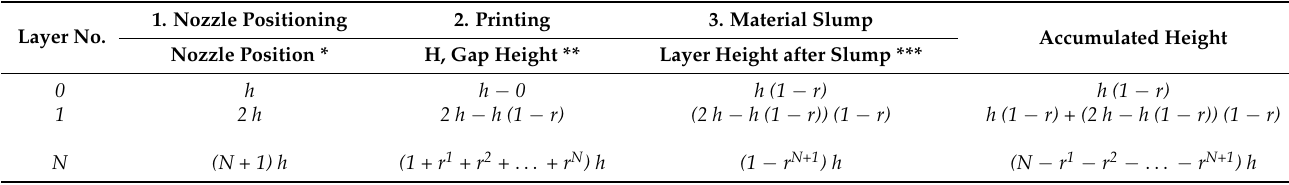
Table 6. Height data during the printing